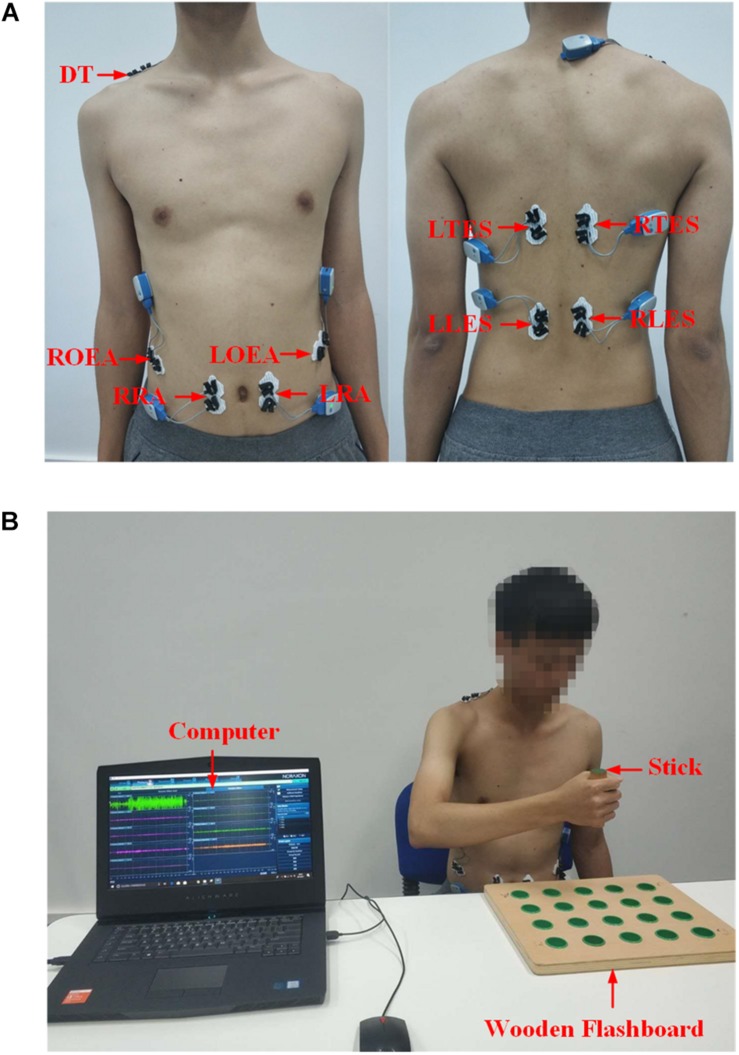
(A) Electrodes placement on trunk muscles. DT, descending part of trapezius; LRA, left rectus abdominis; RRA, right rectus abdominis; LOEA, left obliquus externus abdominis; ROEA, right obliquus externus abdominis; LTES, left thoracic erector spinae; RTES, right thoracic erector spinae; LLES, left lumbar erector spinae; RLES, right lumbar erector spinae. (B) A snapshot of the experiment setup.